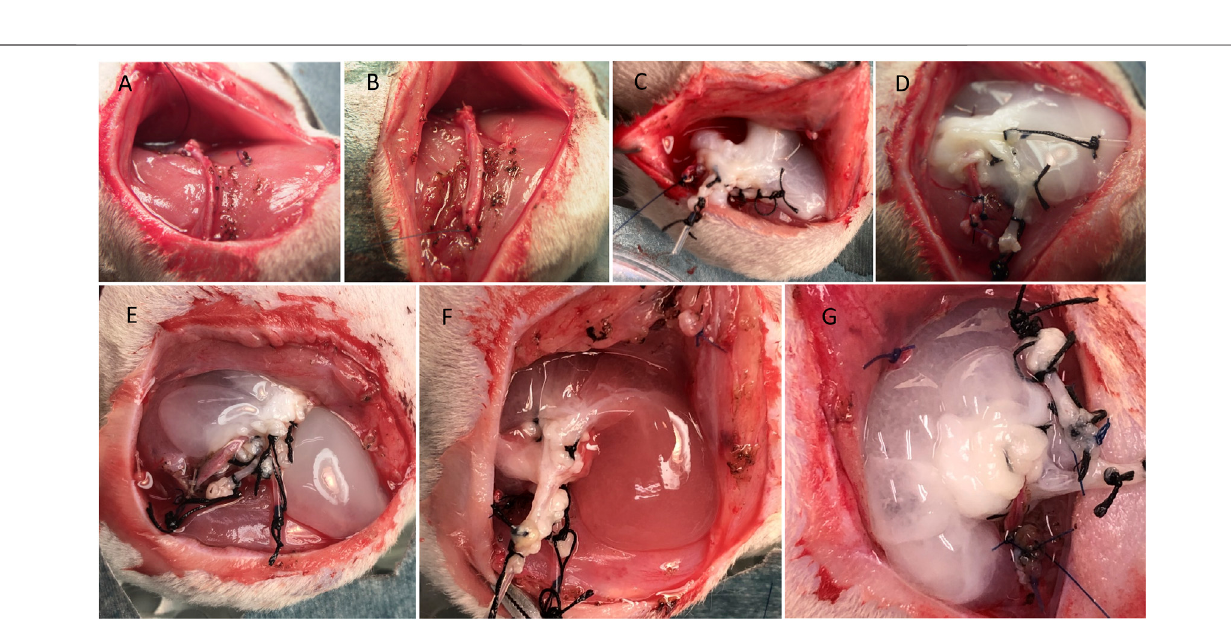
FIGURE4| StepsoftheDLMimplantation. (A) AVbundledissection, (B) ligationoftheAVbundle, (C) implantationoftheliverintheleftthighregionofLewisratand passage of AV bundle, (D) the fi nal con fi guration of the DLM and AV bundle, (E, F, G) injection of HBSS, fresh BM, or ADSCs into the scaffold through the portal vein,